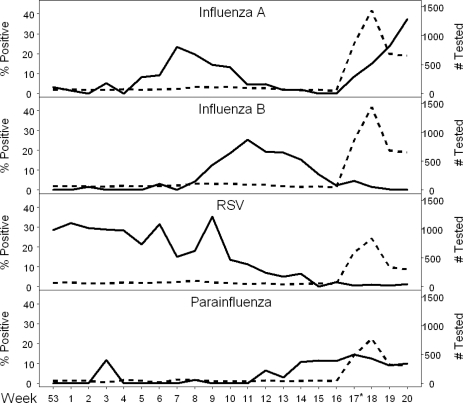
Respiratory virus activity over 2008–2009 winter season by calendar week. Total number of samples tested (as indicated by the dashed line and the righthand y-axis) and proportion positive (as indicated by the solid line and the lefthand y-axis) are depicted for 4 viruses by standard multiplex molecular assays for respiratory viruses. The * indicates the beginning of the S-OIV outbreak in Milwaukee, WI.